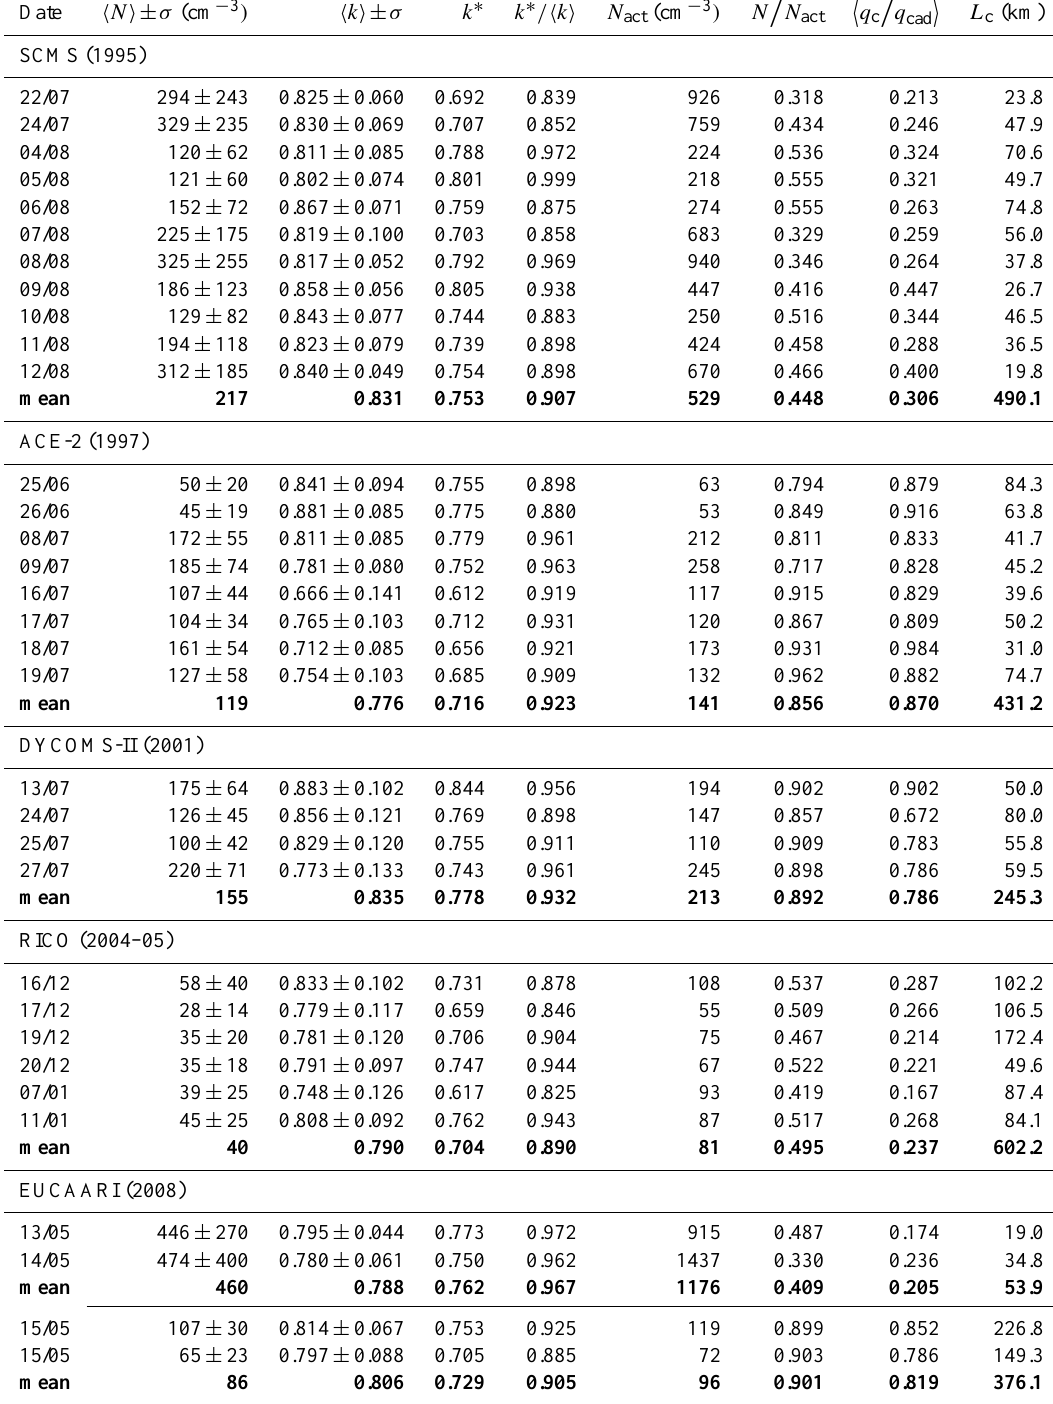
Table 4. Summary of the data set with for each flight the mean and standard deviation σ of CDNC h N i and k values h k i , the k ∗ value, the ratio of k ∗ to h k i , the N act parameter, the ratio N (cid:14) N act , the mean LWC adiabatic fraction (cid:10) q c (cid:14) q cad (cid:11) and the cumulated length of cloudy samples L c . The last line for each data set shows the mean values, except for the last column that shows the total length of cloudy samples. Fast-FSSP measurements are used for all flights except DYCOMS-II on 24, 25 and 27 July for which the SPP-100 is